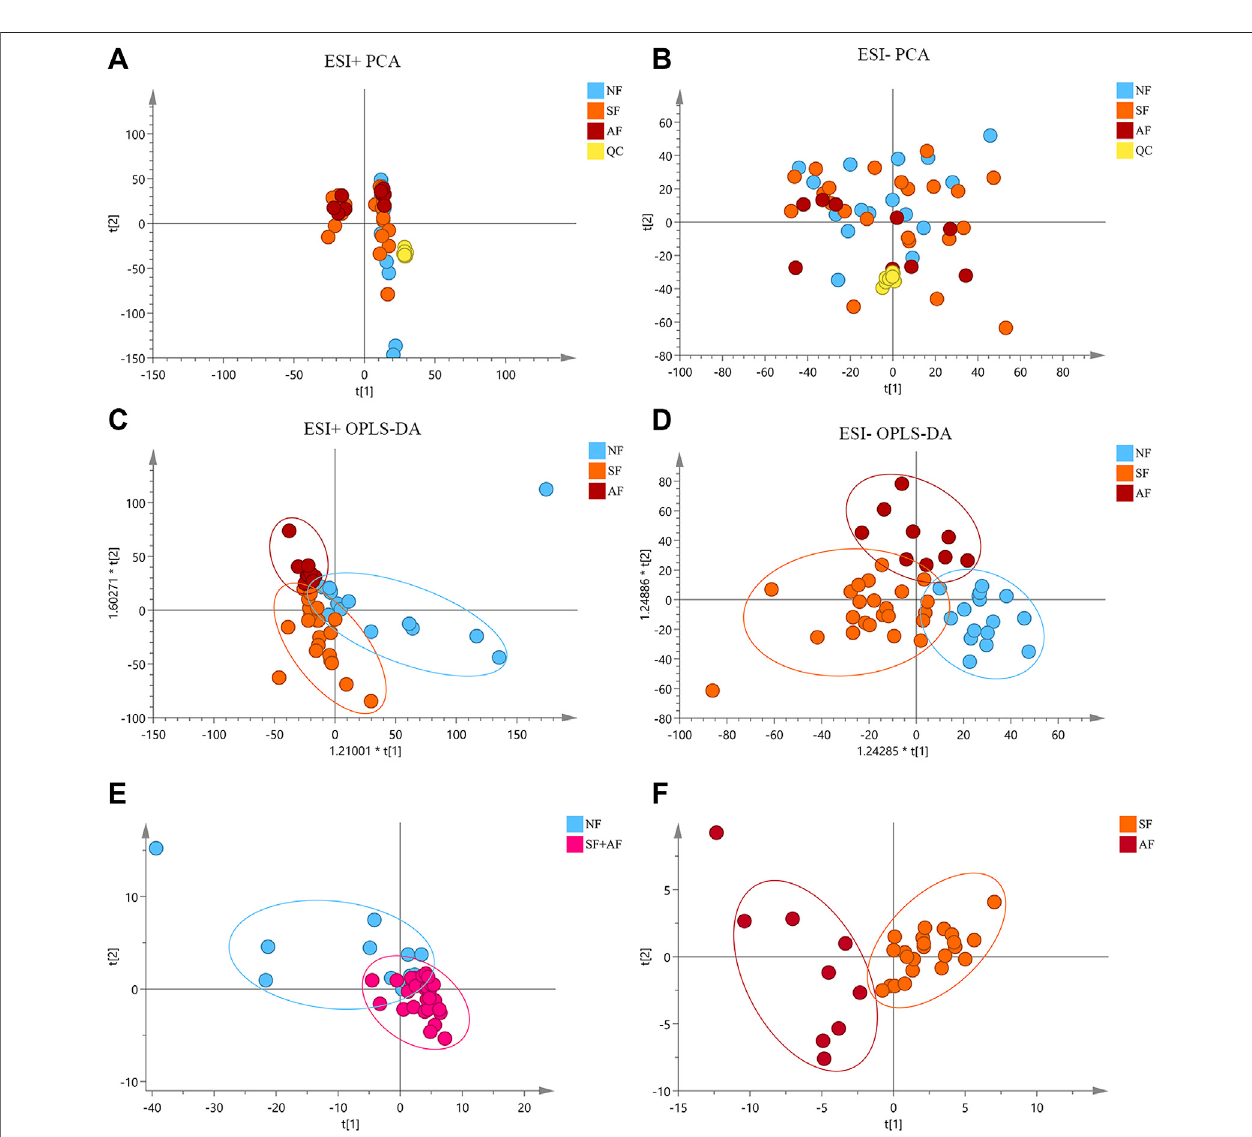
FIGURE 1 | Serum metabolite pro fi le related to fi brosis in patients with chronic DILI. (A,B) Principal components analysis (PCA) of all variables among the NF, SF, and AF groups under the positive and negative models of mass spectrometry. (C,D) Orthogonal projections to latent structures discriminant analysis (OPLS-DA) of all variables among NF, SF, and AF groups under the positive and negativemodels ofmass spectrometry. (E) PCA plot of (SF+ AF) vs. NF with 273annotated metabolites related to fi brosis. (F) PCA plot of SF vs. AF with 96 annotated metabolites related to advanced fi brosis. NF, nonsigni fi cant fi brosis; SF, signi fi cant fi brosis; AF, advanced fi